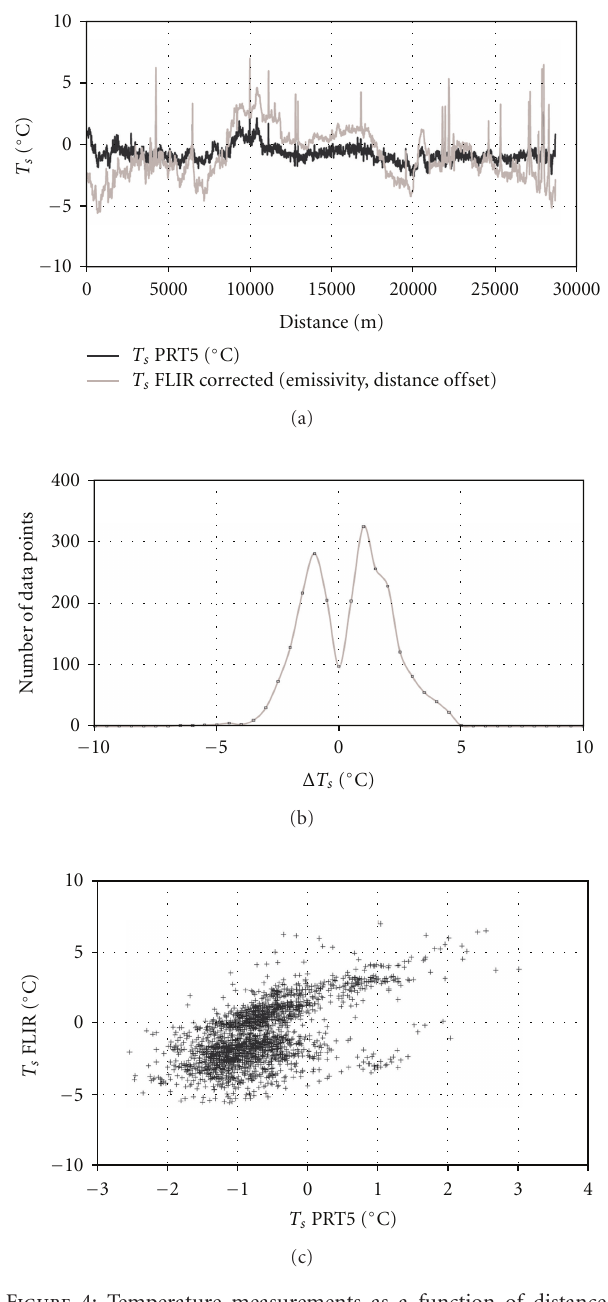
Figure 4: Temperature measurements as a function of distance (emissivity and distance o ff set corrections completed) (a), pave- ment temperature di ff erence Δ T s (b), and surface temperature correlation between the two instruments